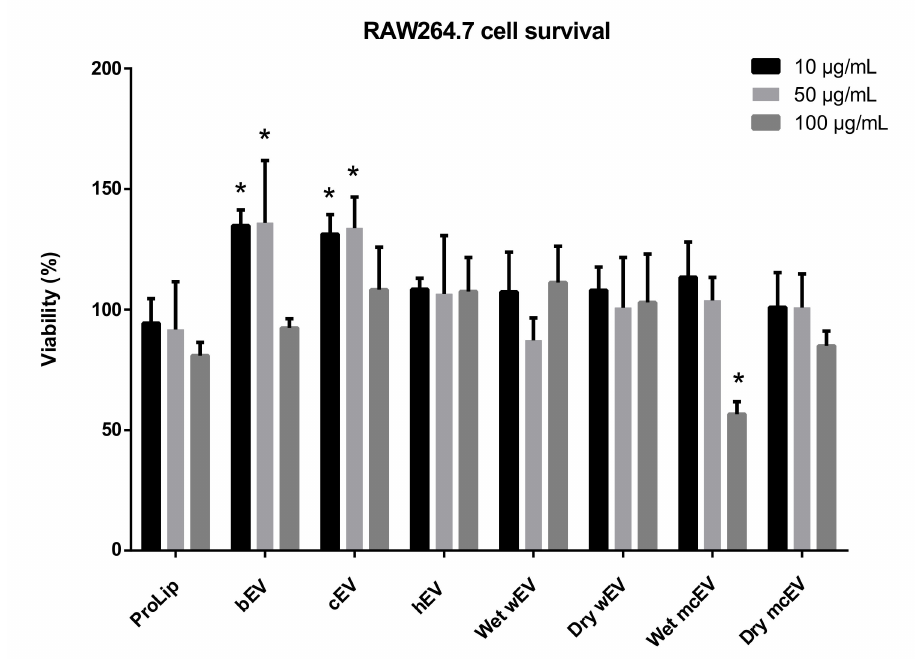
Figure 3. Cell viability after incubation with EV isolates assessed with an MTT assay. RAW264.7 cells incubated for 4 h with 10 µ g/mL, 50 µ g/mL, or 100 µ g/mL of EV protein. The values are calculated from non EV-treated cells grown simultaneously with the EV-treated cells (results not shown). Representative data are presented as means ± SD of four replicas, a minimum of two independent experiments were performed. Differences between control treatment (proteoliposomes, ProLip) and EV treatment were assessed by Student’s t -test. *: p -value < 0.05 vs. the corresponding ProLip treatment. See Table 1 for sample nomenclature.